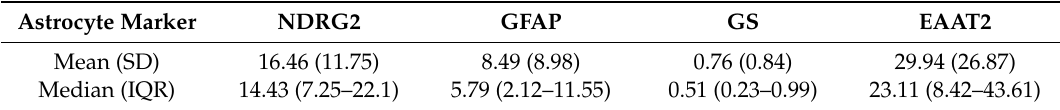
Figure 1. Immunoreactive profiles observed with a panel of astrocyte markers. ( A ) N-myc downstream regulated gene 2 (NDRG2 immunolabelled the astrocyte cell body (as indicated by the arrow) and radiating processes (star). ( B ) excitatory amino acid transporter 2 (EAAT2) extensively immunolabelled the extending processes (star) of astrocytes. Both ( C ) glial fibrillary acidic protein (GFAP) and ( D ) glutamine synthetase (GS) predominantly stained astrocyte cell bodies and immediate cell processes (arrow). Images are representative of the astrocyte immunolabelling profile observed in the temporal cortex of 97 cases. Scale bar represents 50 µ m. Table 1. Comparison of the immunoreactive profile (% area immunoreactivity) of the astrocyte markers NDRG2, GFAP, GS, and EAAT2 in the TCx of an ageing cohort. Astrocyte Marker NDRG2